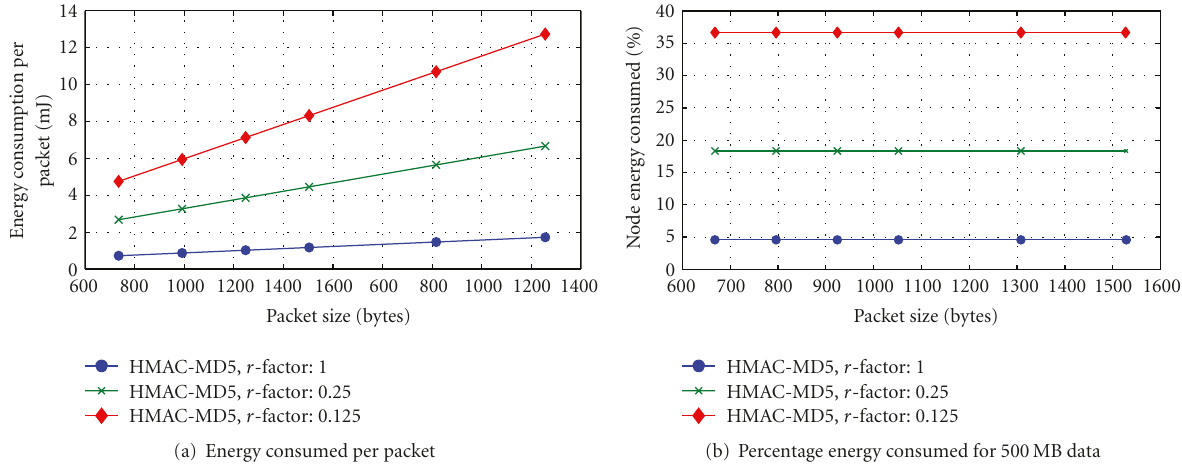
Figure 12: Energy consumption for HMAC-MD5 authentication only, iPAQ H3670.